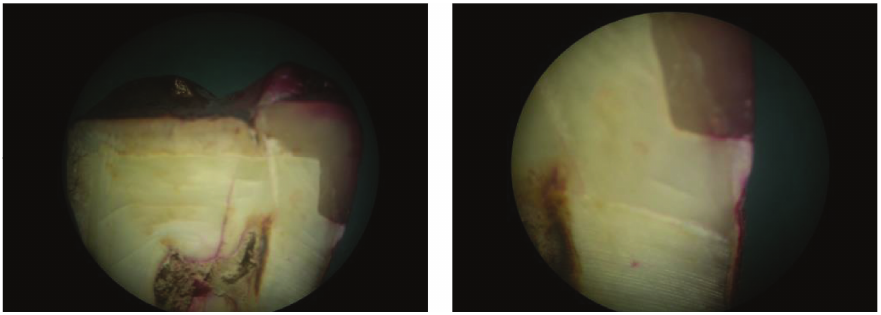
Figure 6: Group 3: microleakage seen under composite restorations with flowable composite liner, cocure group.